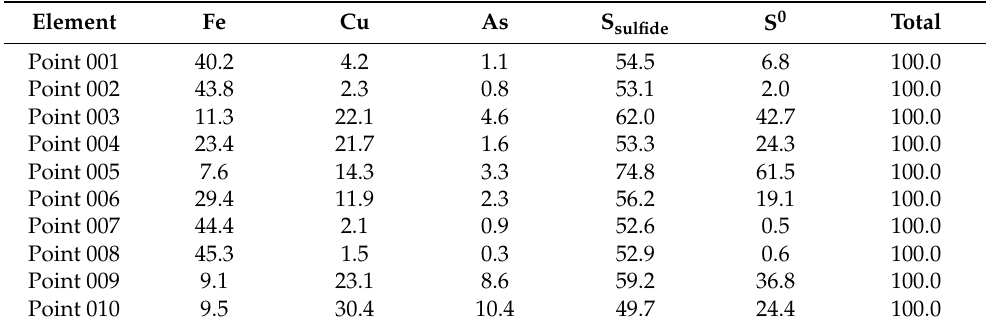
Table 3. Typical SCM kinetic equations applied for systems with spherical particles.